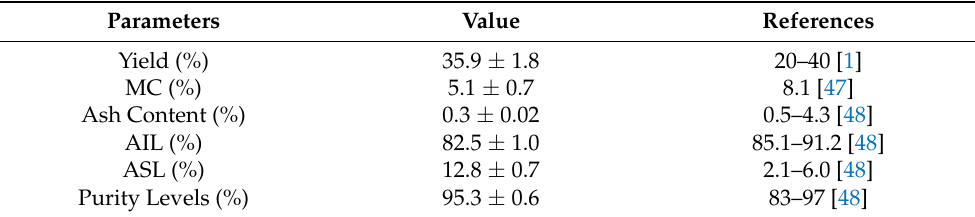
Table 1. Characteristics of isolated lignin.